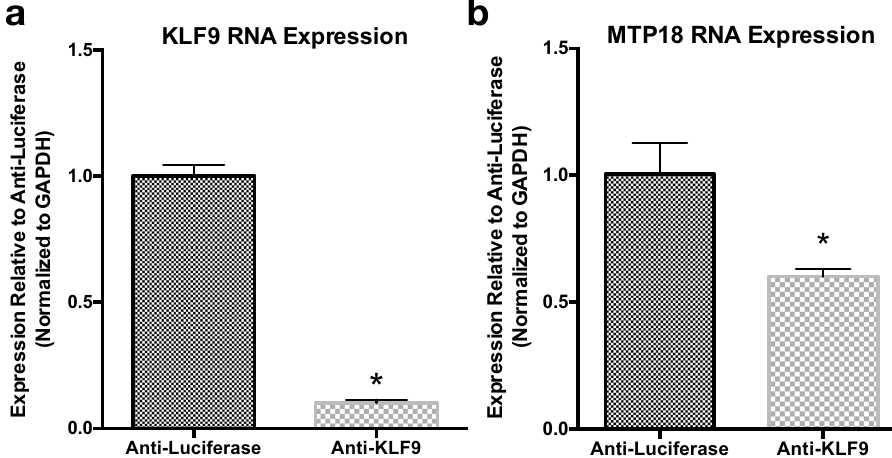
Figure 3. MTP18 expression is regulated downstream of KLF9 expression. ( a ) KLF9 mRNA expression after AAV2 mediated expression of shRNAs targeting KLF9 (Anti-KLF9) and luciferase (Anti-luciferase) mRNA in cultured P4 RGCs. ( b ) MTP18 mRNA expression in P4 RGCs after AAV2 mediated Anti-KLF9 or Ant-luciferase vector expression. All data captured by QRT-PCR, normalized to GAPDH and expressed as mean expression relative to Anti-luciferase (N = 3 replicate treatments, significance ascribed by Student’s t-test, * p ≤ 0.05). All error bars represent +